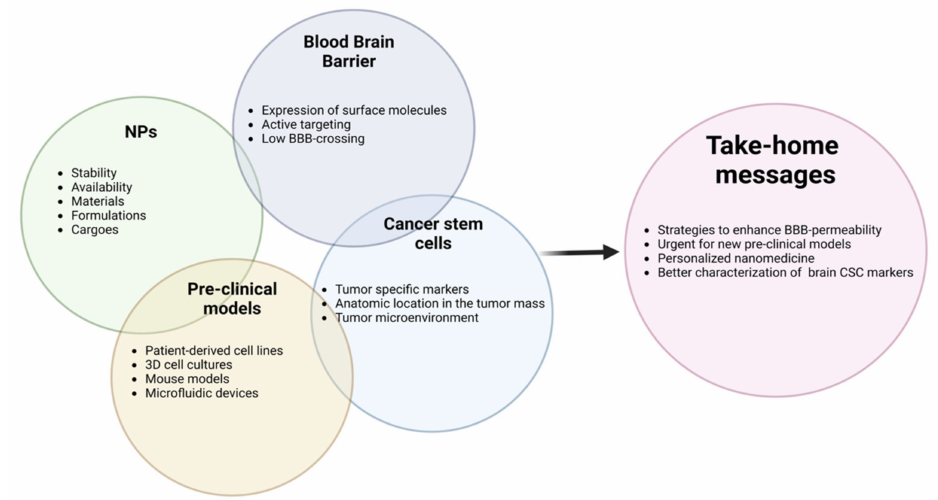
Figure 4. Overview of the main aspects affecting nano-delivery strategy in pediatric brain cancer and future aims